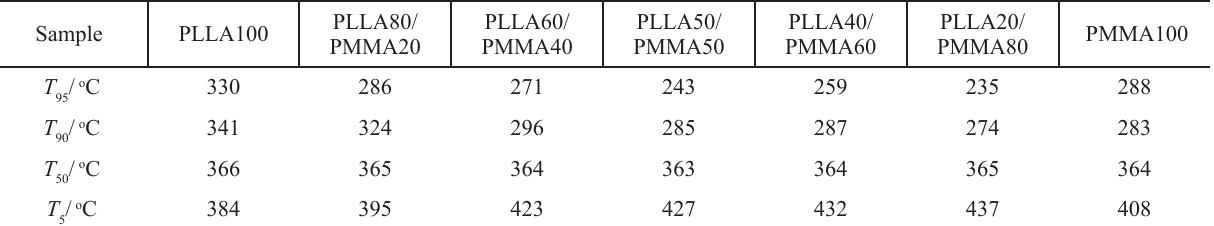
Table 4 – Thermal degradation data of poly(L-lactic acid) – PLLA, poly(methyl methacrylate) – PMMA, and their blends